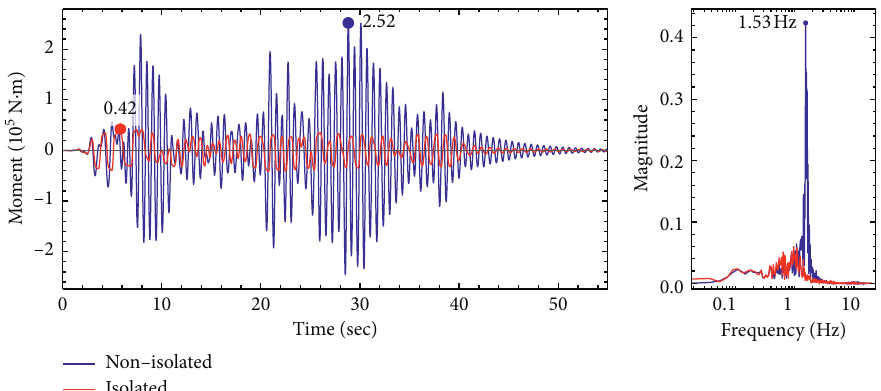
Figure 14: Response histories and corresponding Fourier spectra of the base moment of the nonisolated and isolated system with 2% damping at 0.2 (g) seismic qualification level under α � 0.